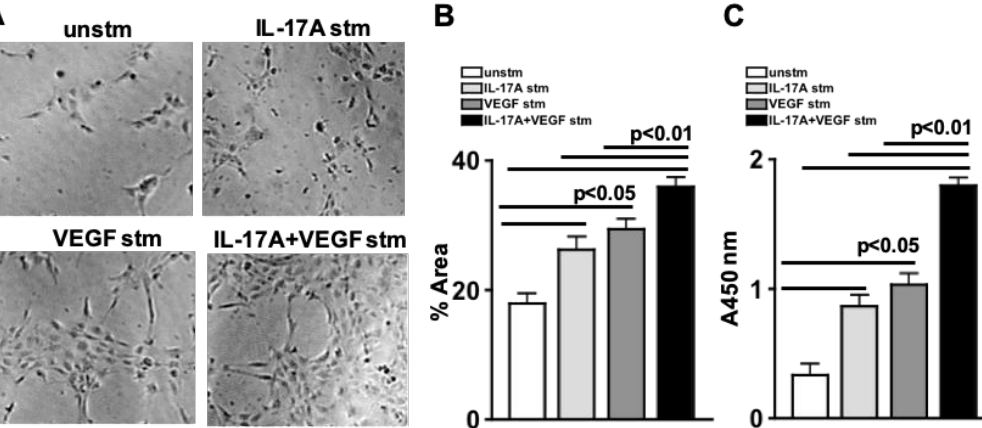
Figure 4. IL-17A Enhances Retinal Endothelial Cell Angiogenesis. ( A ) Representative phase contrast images of unstimulated or stimulated human retinal endothelial cells. Quantification of the percentage of proliferation area ( B ), or BrdU quantification of proliferation ( C ) in unstimulated (white), IL-17A-stimulated (light grey), VEGF-stimulated (dark grey), or IL-17A+VEGF-stimulated (black) human retinal endothelial cells. Error bars represent the SEM. All p -values were first equated by two-way ANOVA and then unpaired Student’s t - test with Tukey’s post -hoc analysis.